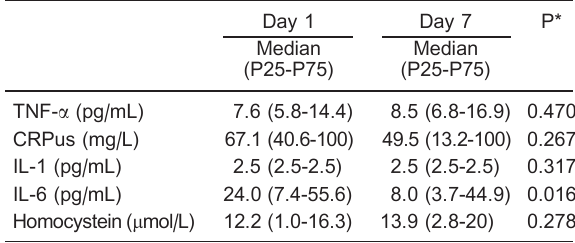
Table 1. TNF- a , CRPus, IL-1, IL-6, and homocystein levels in serum at admission (day 1) and day 7.